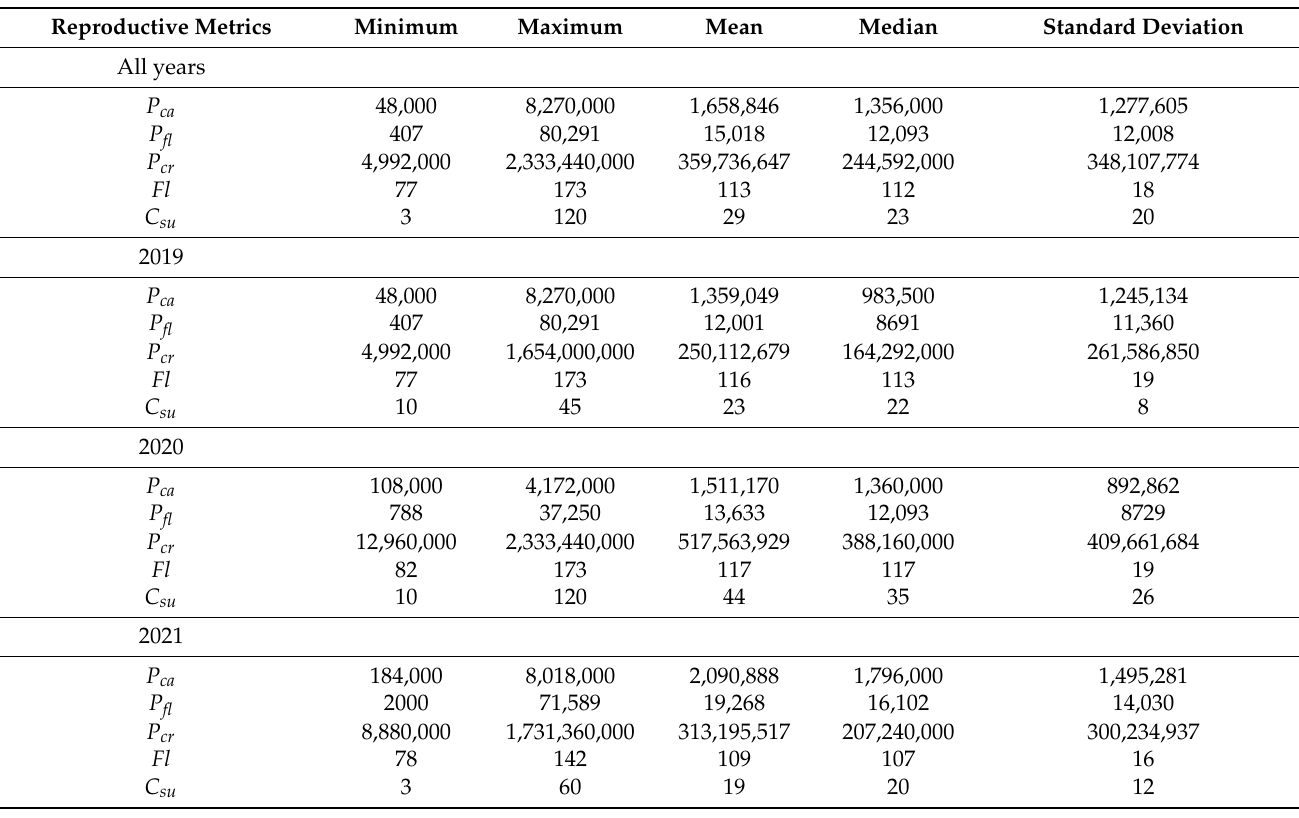
Table A1. Descriptive statistics of pollen production per catkin ( P ca ), pollen production per flower ( P fl ), pollen production per volume unit of crown ( P cr ), flowers per catkin ( fl ) and catkins per crown sampling unit ( C su ; 0.125 m 3 ) (minimum, maximum, mean, median and standard deviation) estimated from 28 selected birch trees of the seed plantation Wildberg during